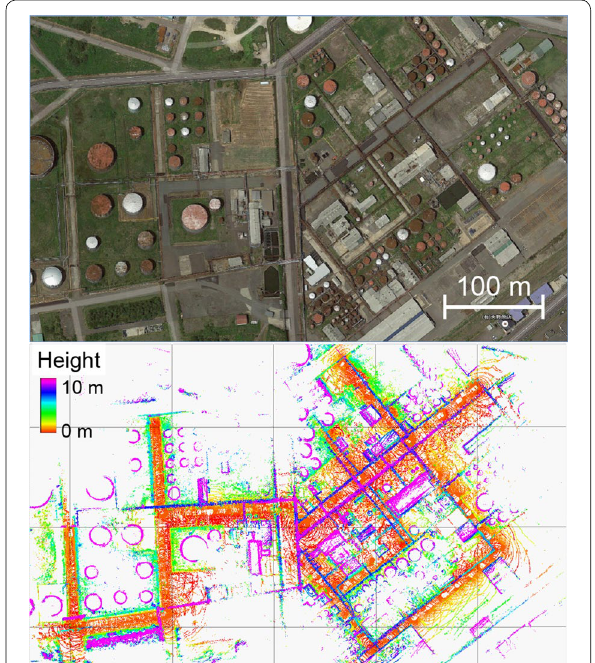
Fig. 1 Result of petrochemical complex (380–550 m) consistency: map for Fast-SLAM 2.0 in a grid map based on GPS and LIDAR (bot- tom) compared to an aerial map (top)